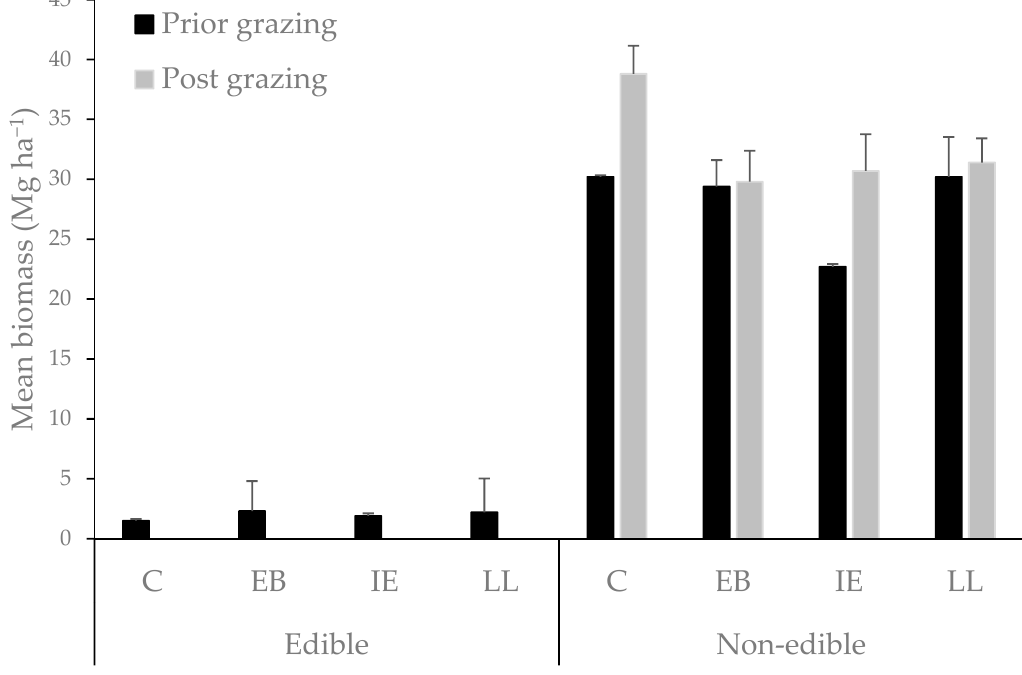
Figure 5. Mean average dry biomass of edible and non-edible fractions of grass (Mg ha − 1 ) produced in the four treatments: Erythrina berteroana (EB), Inga edulis (IE), Leucaena leucocephala (LL), and a no-tree, grass only control (C), reported for destructive sampling carried out prior to and post the introduction of cattle. ‘Edible fraction’ was visually assessed as the leaf or stem (<25 mm) component of the grass no less than 10 cm from the ground. ‘Inedible fraction’ refers to the remaining fibrous and structural herbaceous biomass considered to be of lesser nutritional value to cattle. Error bars represent standard error values.